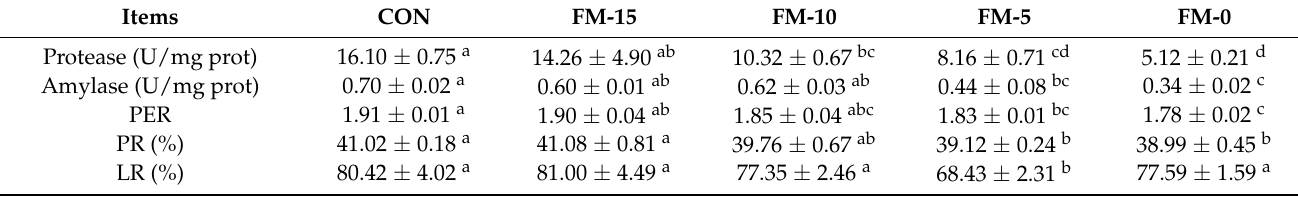
Table 5. Effect of replacing fishmeal with CPC and CAP mixture on nutrient utilization and intestinal digestive enzymes of rainbow